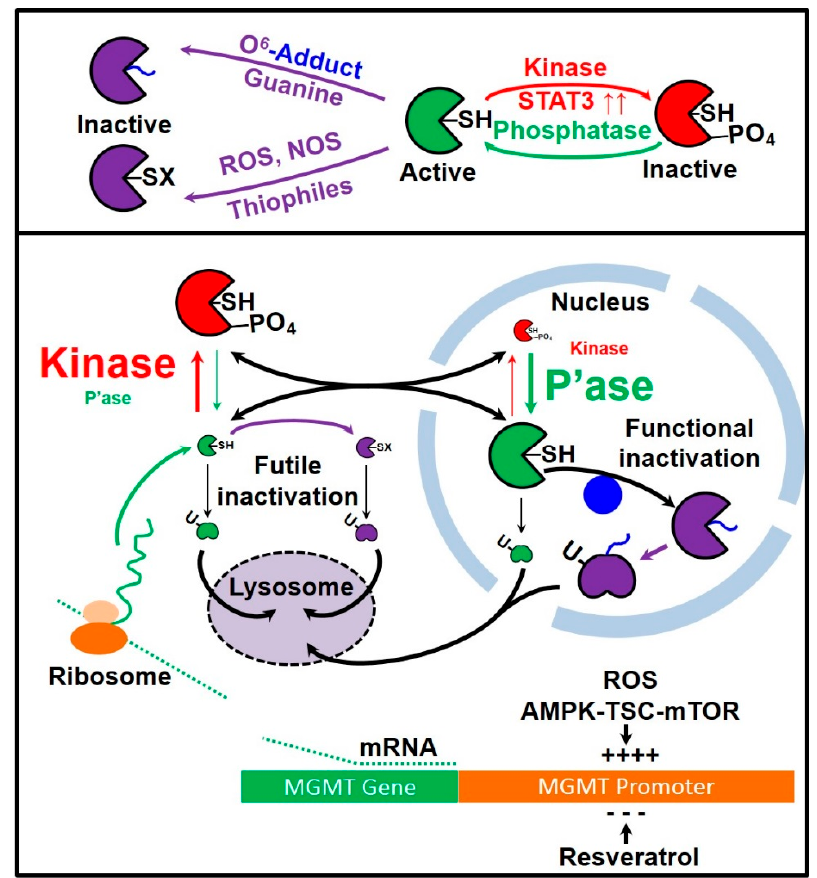
Figure 8. MGMT lifecycle in cancer cells. Figure key: PO 4 —phosphate group; -SH—thiol group of Cys145 in MGMT; -SX—inactivated MGMT; P’ase—phosphatase; U—ubiquitin.